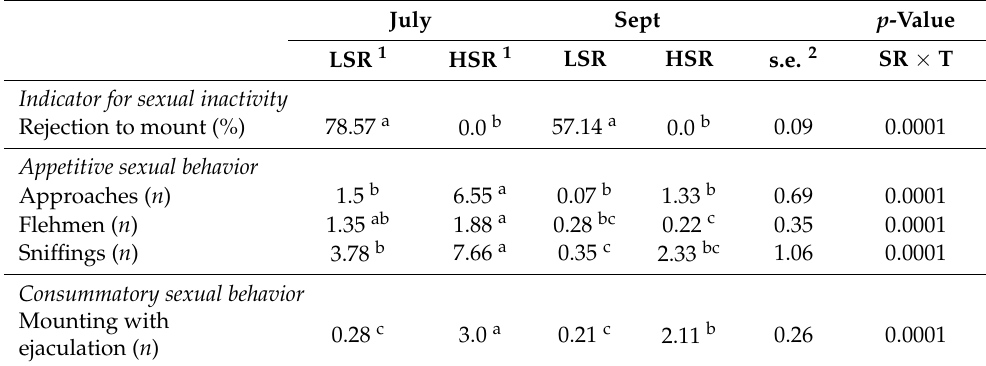
a,b,c Least squares means lacking a mutual superscript within response variable (i.e., lines) differ ( p < 0.05). 1 A behavioral test was carried out in July to define the social ranks, either low (LSR) or high (HSR). 2 Most conservative standard error is